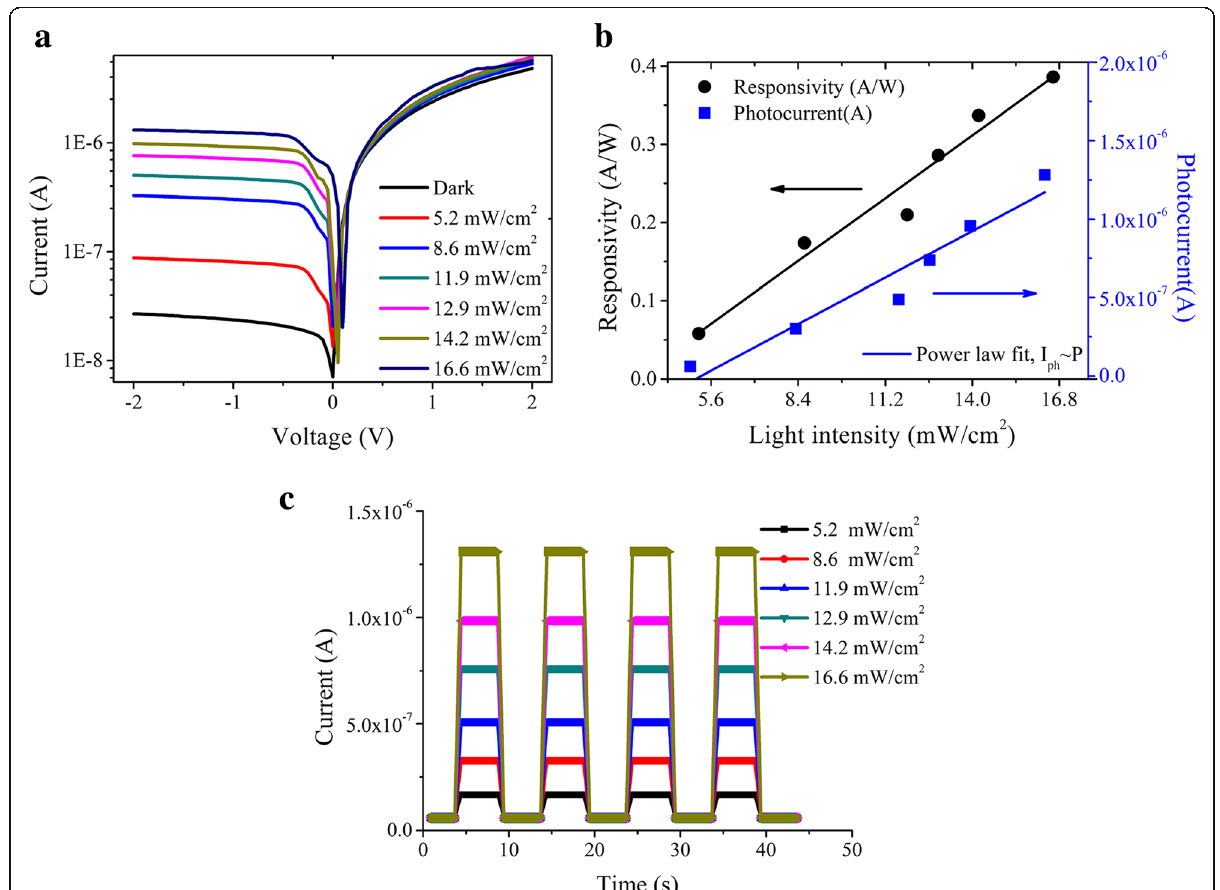
Fig. 6 The photo-electron properties of the fabricated detector with the plasmonic resonator. a Logarithmic I - V curves of the detector measured in dark and under different illumination intensities. b The curves of the responsivity changing with the illumination intensity under the bias of − 2 V. c I-t response of the photodetectors under different illumination intensities at − 2 V